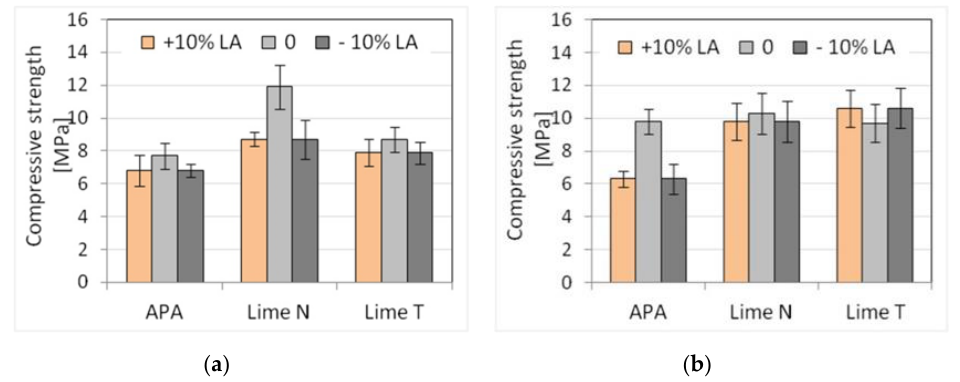
Figure 10. Influence of mistake in dosing lime and admixture on compressive strength of ( a ) plaster, ( b ) masonry mortars. ( b ) masonry